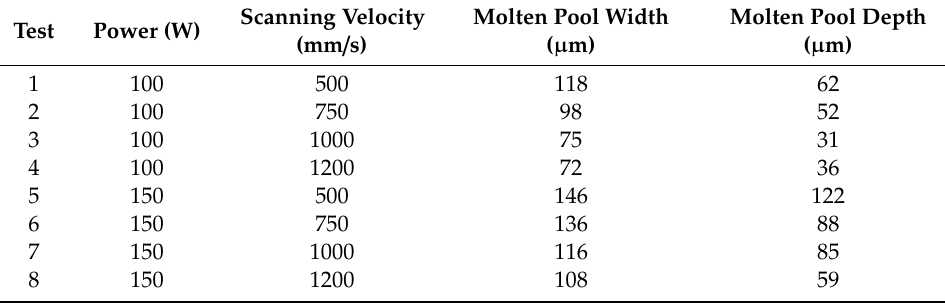
Table A1. Experimental molten pool dimensions